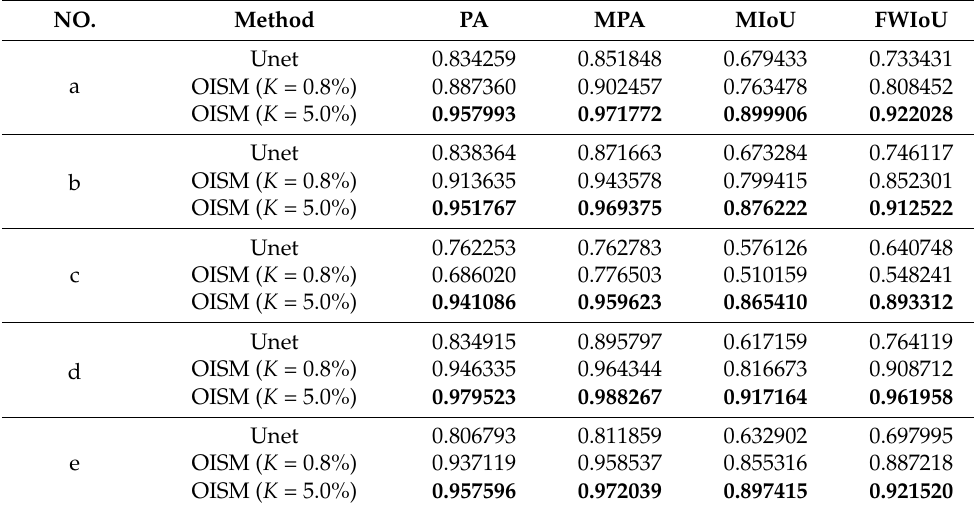
Table 2. Comparison of the evaluation indexes between the Unet and the OISM methods with typical